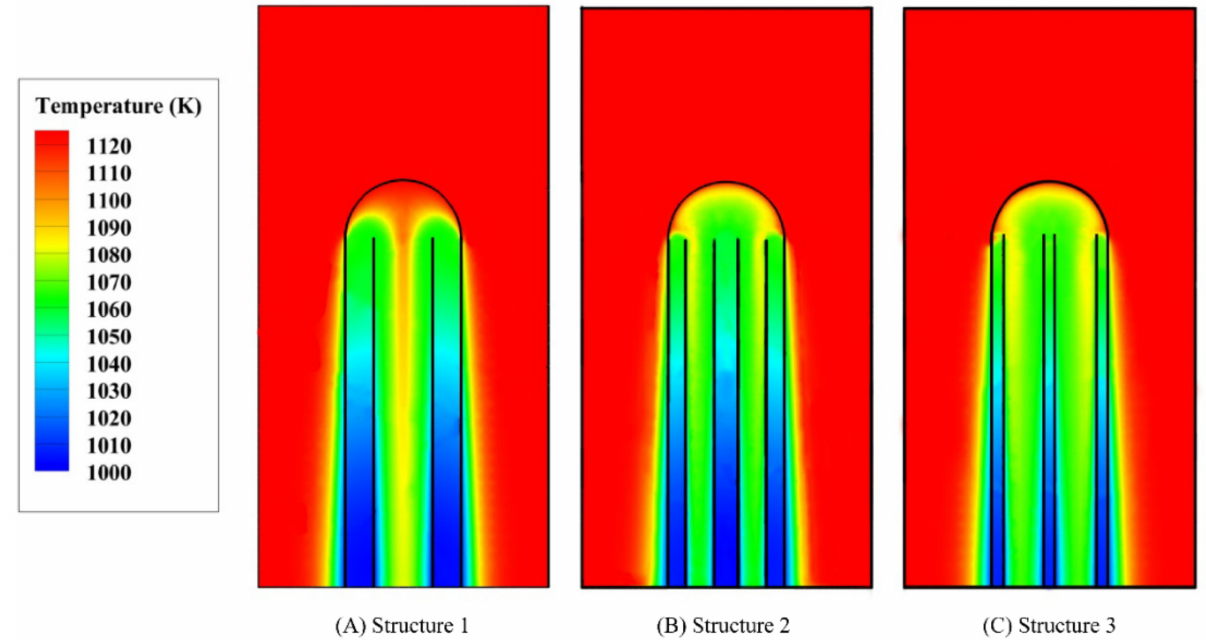
Figure 6. Temperature distribution in the bayonet heat exchanger for an inlet flow rate of 0.00035 kg/s. ( A ) Structure 1, ( B ) Structure 2, ( C ) Structure